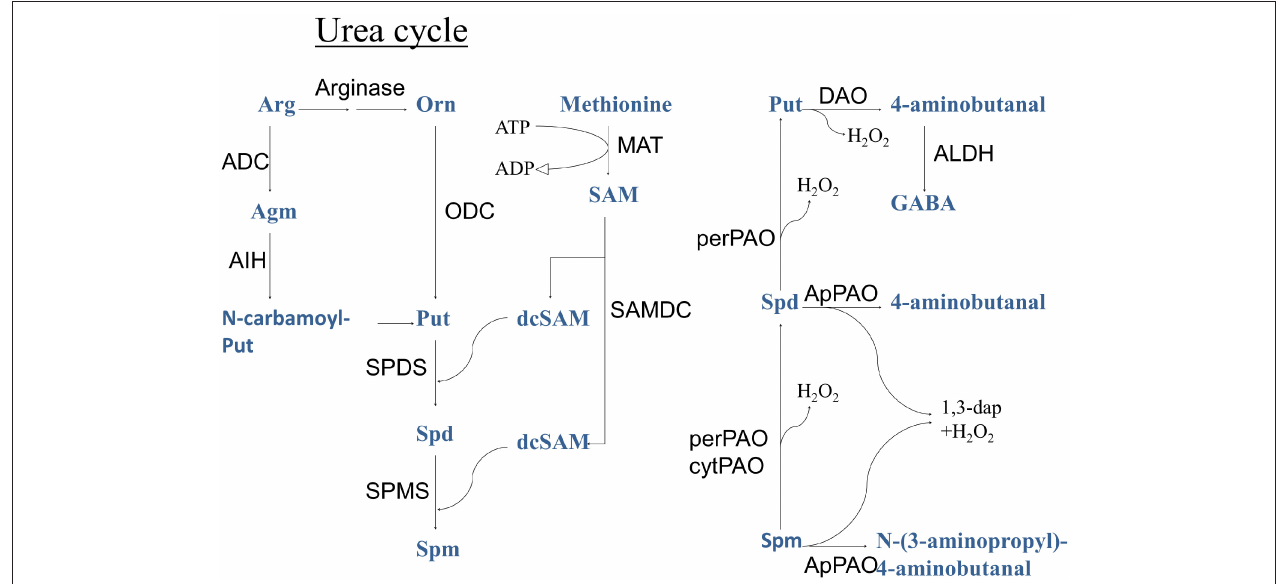
FIGURE 1 | Polyamine metabolic pathway. ADC, arginine decarboxylase; ALDH, aldehyde dehydrogenase; Cad, cadaverine; CuAO, copper amine oxidase; dcSAM, decarboxylated S-adenosyl-L-methione; LDC, lysine decarboxylase; MAT, methionine adenosyltransferase; ODC, ornithine decarboxylase; PAO, polyamine oxidase (per, peroxisomal; ap, apoplastic; cyt, cytoplasmic); SAM, S-adenosyl-L-methione; Spd, spermidine; Spm, spermine; PMT, putrescine N -methyl transferase; Put, putrescine; SAMDC, S-adenosyl-L-methione decarboxylase; SPDS, spermidine synthase; SPMS, spermine